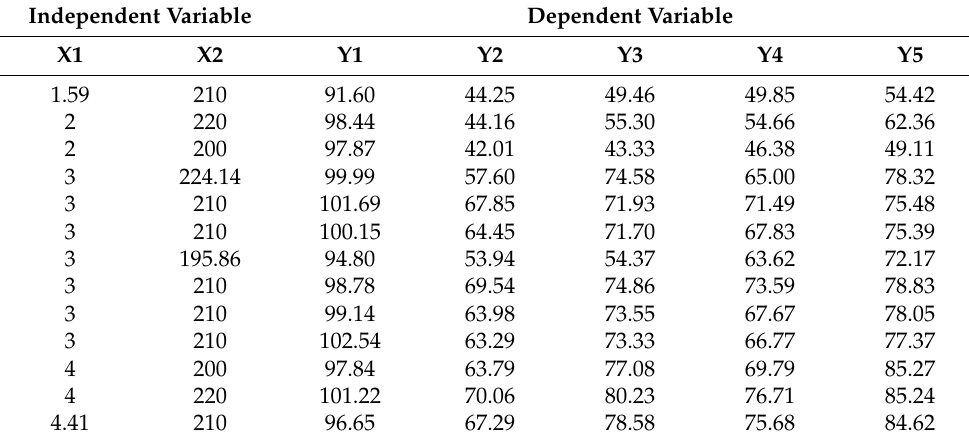
Table 4. Experimental design of hot-melt extruded RXB-ASDs by CCD.